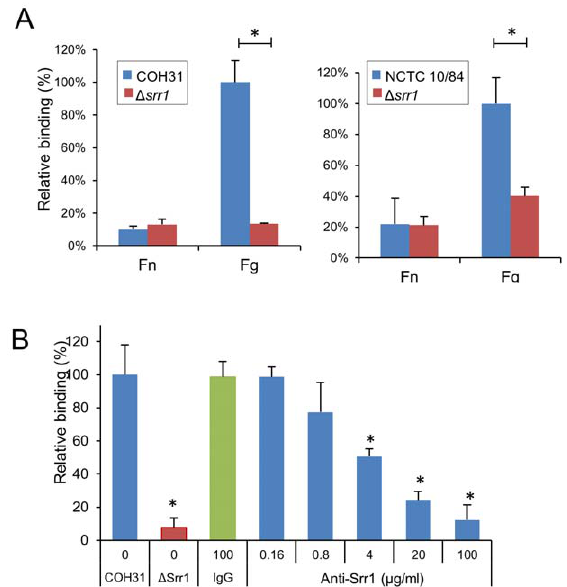
Figure 3. GBS binding to fibrinogen is mediated by Srr1. (A) GBS strains COH31 (left) and NCTC 10/84 (right) were compared with their D srr1 variants ( D srr1 ) for binding to the wells pretreated with fibronectin or fibrinogen (0.1 m M per well). (B) Inhibition of GBS binding to fibrinogen by anti-Srr1 IgG. COH31 strain was co-incubated with rabbit anti-Srr1 IgG or normal rabbit IgG, and relative binding to immobilized with fibrinogen. Values are mean 6 S.D. of relative binding, normalized for WT levels of binding to fibrinogen. *=P , 0.01.